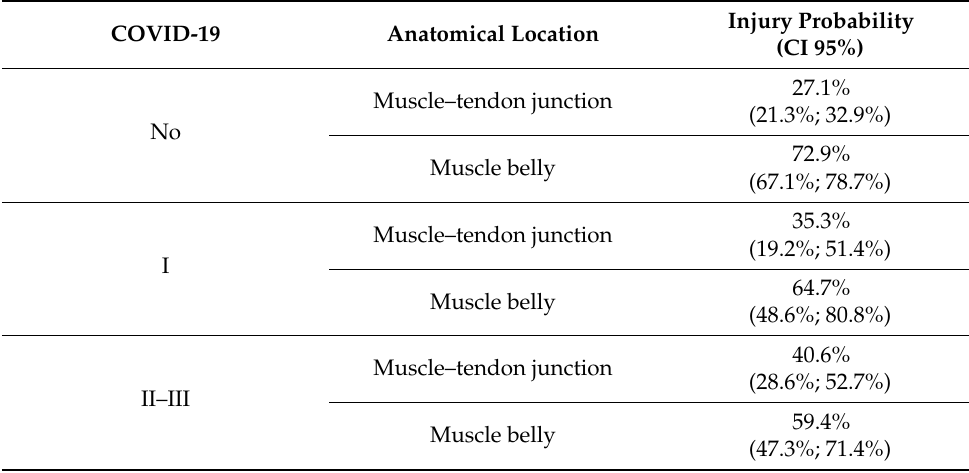
Table 5. Estimates of the proportion of muscle injury, and corresponding CI 95%, according to different anatomical locations computed using a multinomial regression